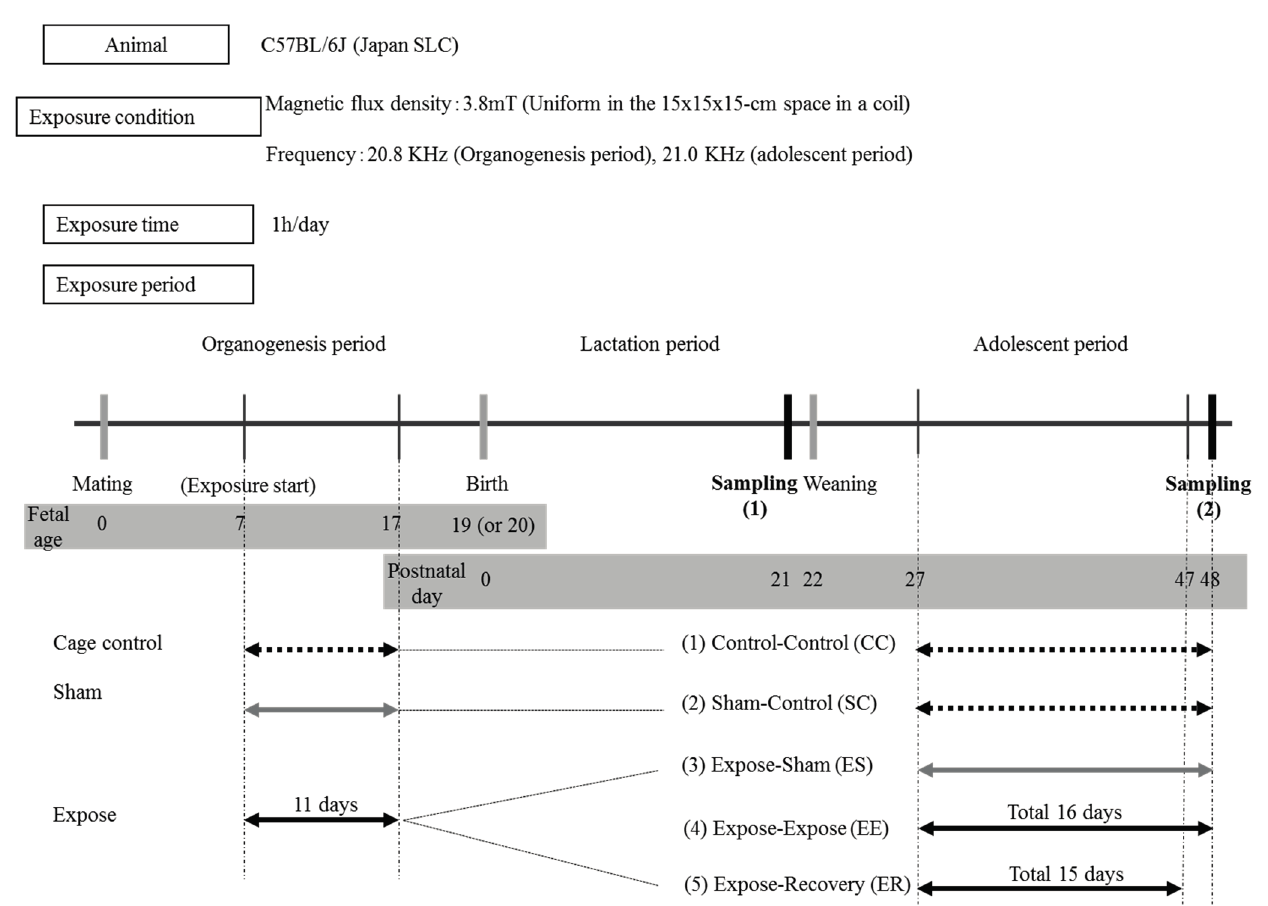
Figure 1. Experimental protocol. Organogenesis and adolescent IF-MF exposure were performed from GD 7 to 17 (total 11 days) and from PND 27 to 48 (Actual experiment period was 22 days which contained 16 exposure days plus 6 week-ends unexposed days), respectively. IF-MF exposure was performed at 21 kHz, 3.8 mT for 1 h per day.